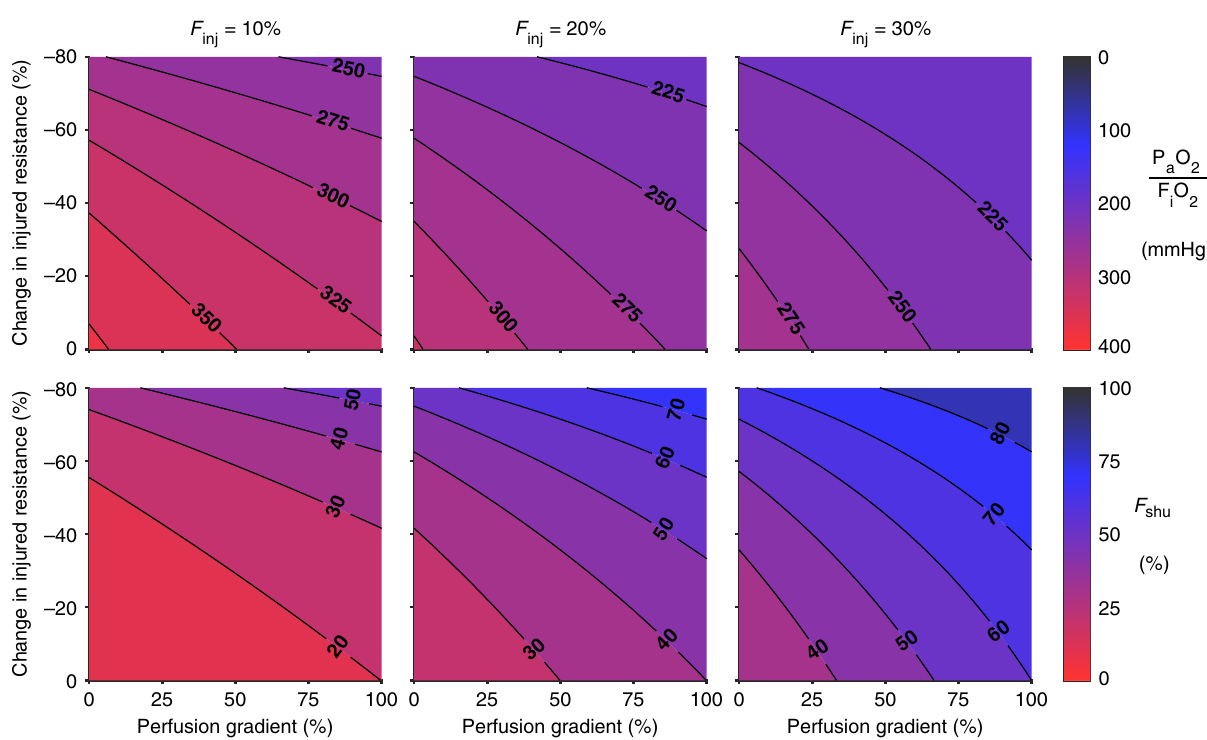
Fig. 3 Hypoxemia worsened by increased perfusion to the injured lung. Hypoxemia severity maps with respect to perfusion gradient and percent change in vascular resistance within the injured compartment of the lower lung zone. Top row shows contours of the ratio of arterial oxygen tension to inspired oxygen fraction ( P a O 2 : F i O 2 ). Bottom row shows contours of the shunt fraction ( F shu ). Columns represent different levels of the fraction of lung injured ( F inj ).